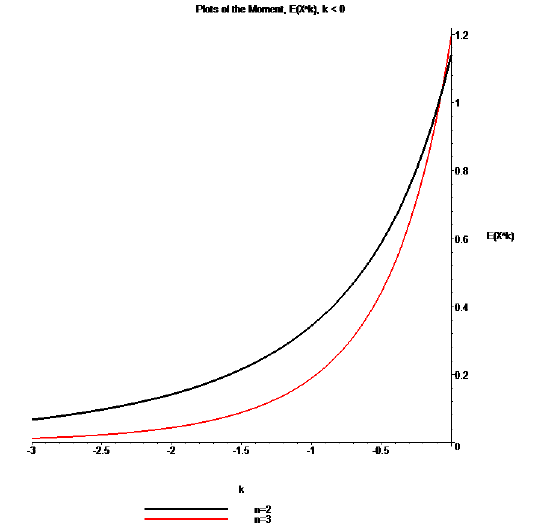
√ 2 ≤ x ≤ 1000 and n = 3 ,